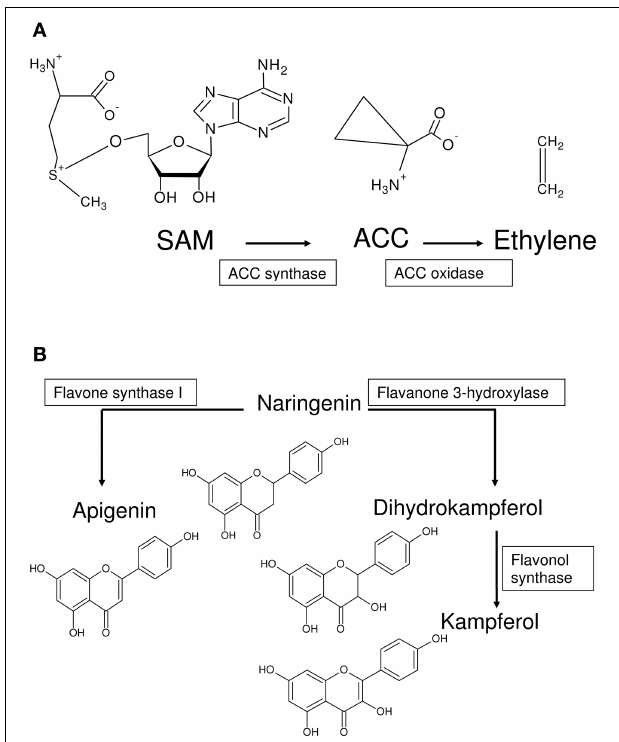
FIGURE 6 | Generation of metabolic bias in pathways utilizing 2OG-dependent enzymes. (A) S-adenosylmethionine (SAM) is the substrate for ACCS, an EFE, and Nicotianamine (NA). In graminaceous plants, NA is converted to the mugineic acids. ACCO catalyzes the final step in the synthesis of ethylene, and maybe a critical player in the iron-deficiency sensing mechanism. (B) p -coumaroyl-CoA (not shown), is another metabolite at a branch point of two competing pathways. Naringenein, synthesized from CHS, is the first committed step in the synthesis and accumulation of flavonoids. The polyhydroxylated nature of these compounds and their metal chelation are important for their biological roles as antioxidants. The alternate metabolic route leads to the synthesis of lignins, which are used to strengthen the cell wall.